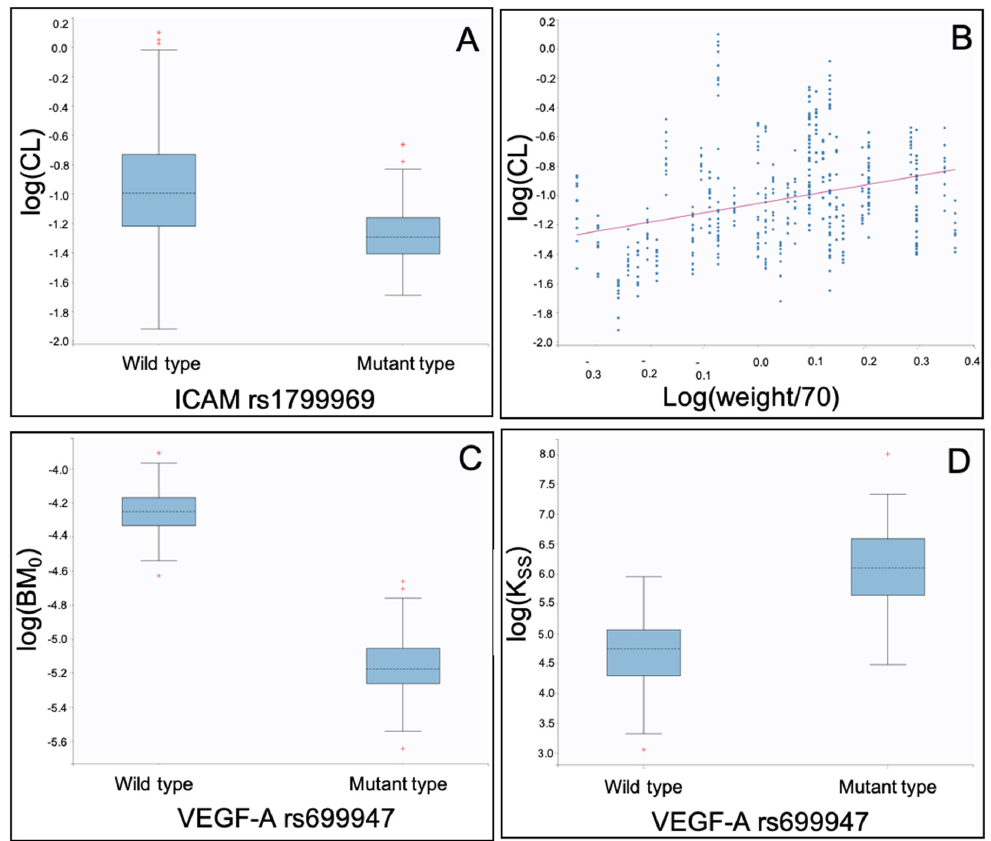
Figure 2. Individual pharmacokinetic parameter estimates of the binding QSS model vs. co-variates identified: ( A ) log(CL: Clearance) vs. ICAM-1 rs1799969; ( B ) log(CL: Clearance) vs. log(weight/70); ( C ) log(BM 0 : Baseline VEGF-A levels) vs. VEGF-A rs699947; and ( D ) log(K ss : Steady-state constant) vs. VEGF-A rs699947. VEGF-A